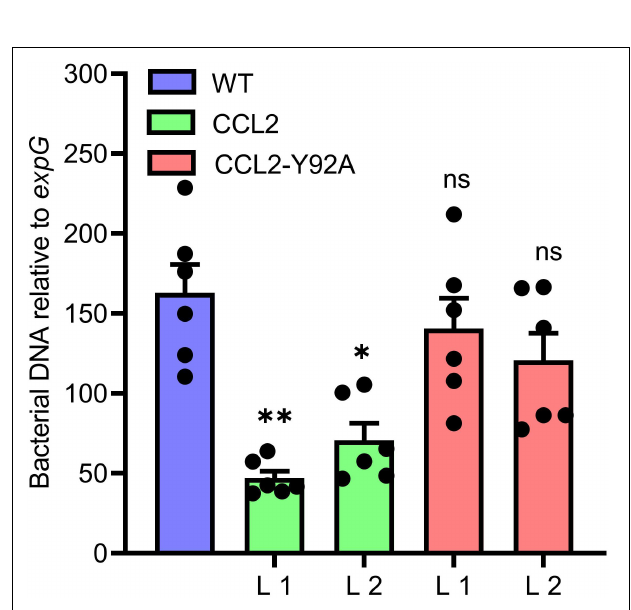
FIGURE 5 | Increased resistance of CCL2-lines toward the bacterial pathogen P. syringae . Growth of virulent Pst DC3000 in WT plants and CCL2 lines was analyzed at 3 dpi. The bacterial oprF gene was quantified by qPCR using DNA extracted from inoculated leaves. Ten leaf discs from six plants were sampled per replicate. The plant expG gene served as reference. Data represent mean values ± SE of three independent experiments ( n = 18). Asterisks indicate statistically significant differences ( ∗ P ≤ 0.05, ∗∗ P ≤ 0.01, ns: not significant; one-way ANOVA and post hoc analysis with